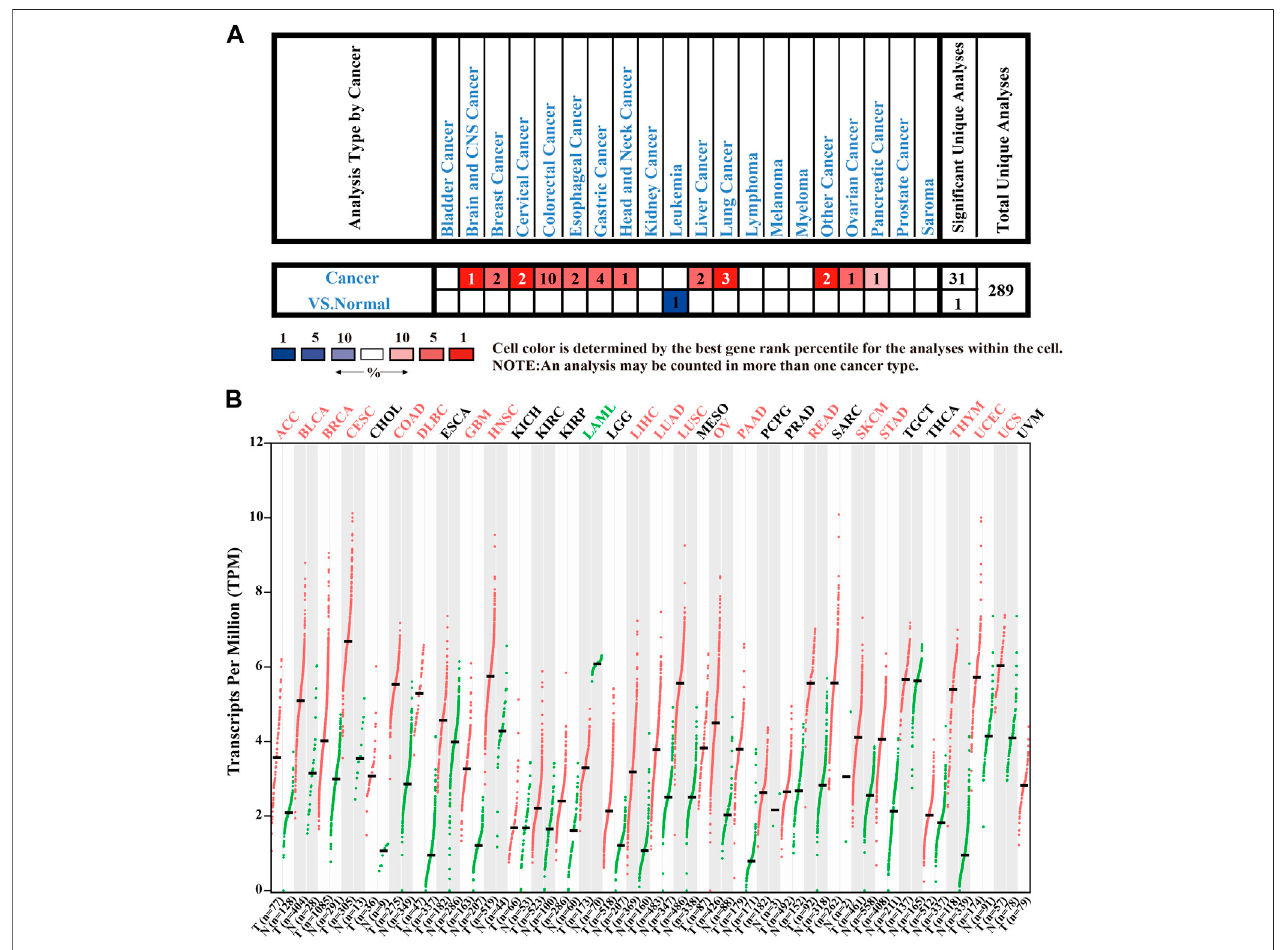
FIGURE 1 | The expression levels of CENPW in different tissues. (A) The CENPW expression in multifarious tumor tissues and its corresponding normal tissues in the Oncomine database. (B) The CENPW expression in diverse types of carcinomas and normal tissues in GEPIA database.